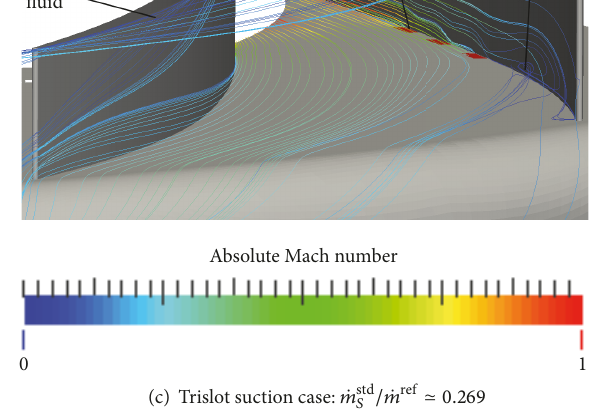
Figure 8: Three-dimensional